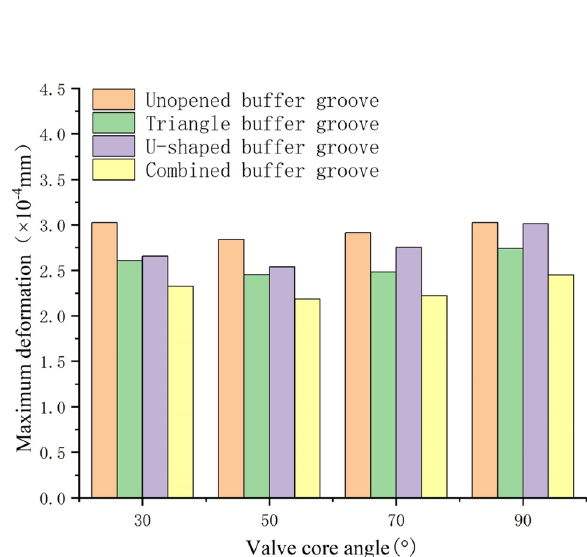
Figure 21. Deformation of valve sleeve and spool in each buffer